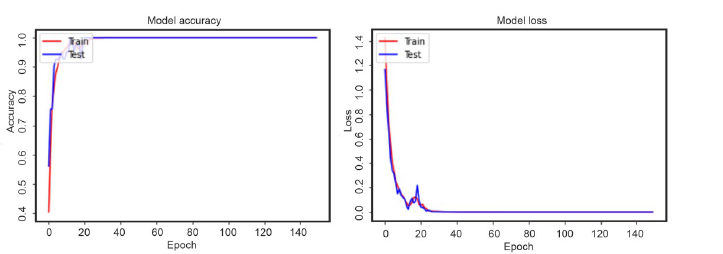
Fig 7. Accuracy of the model and the loss function for left-handed punches.